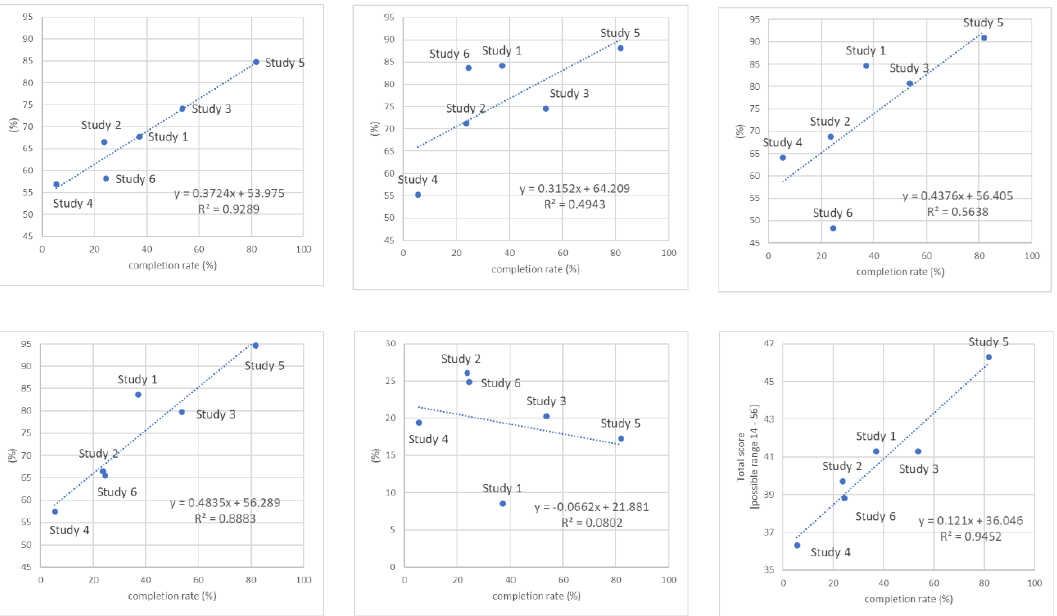
Figure 1. The association of implementation outcomes measured by iOSDMH with completion rate of the digital mental health programs.